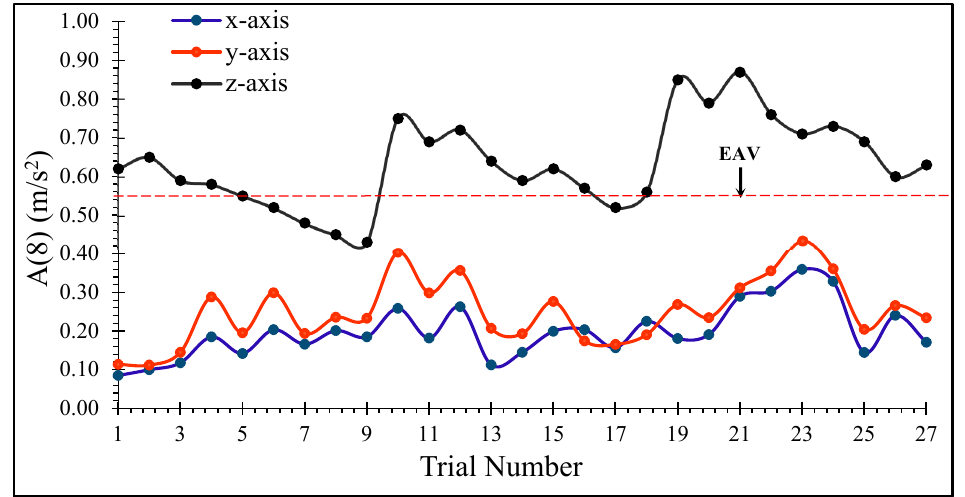
Figure 3. A(8) response along the translational axes ( x -axis: longitudinal direction; y -axis: lateral direction; z -axis: vertical direction; EAV: exposure action value).